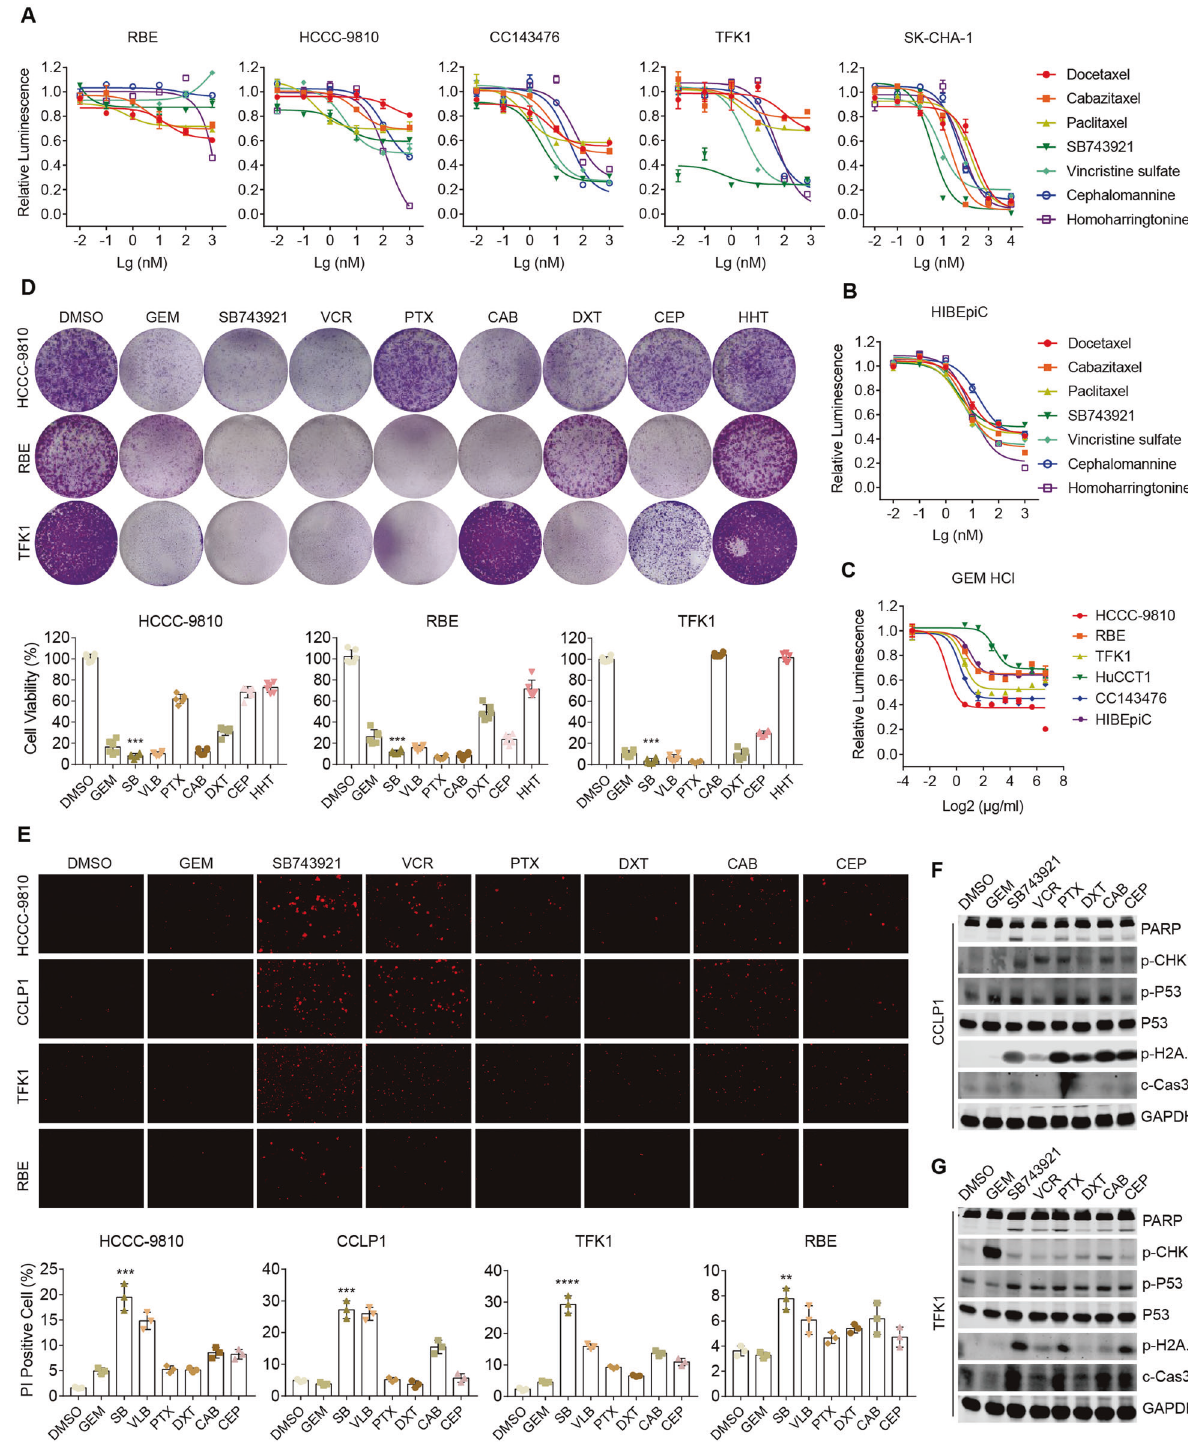
Fig. 2 The therapeutic effect of SB743921 on CCA cell lines. A , B Cell sensitivity to drugs treatment. CCA cell line HCCC-9810, RBE, CC143476, TFK1, SK-CHA-1, and normal counterpart cell line HIBEpiC were treated with drugs at gradient concentrations (0.001, 0.01, 0.1, 1 μ M) for 72 h. Values shown in the chart are the mean percent viability of control ± SD obtained from three independent experiments. C Cell sensitivity to gemcitabine treatment. D Colony formation assay of HCCC-9810, RBE, and TFK1 cells after drugs treatment (0.01 μ M, 7 days). Drugs were paclitaxel (PTX), docetaxel (DXT), cabazitaxel (CAB), vincristine (VCR), and cephalomannine (CEP), homoharringtonine (HHT) or gemcitabine (GEM). Bar graphs show representative data from three independent experiments. E Cell viability assessment of HCCC-9810, CCLP1, TFK1, and RBE cells treated with drugs (0.25 μ M, 24 h) by PI staining. Bar graphs show the mean percentage of PI-positive cells from three independent experiments. F , G Immunoblot analyses of the expression of PARP, p-CHK1, p-P53, p-H2A.x, and c-Caspase3 in CCLP1 and TFK1 cells after drugs treatment (0.25 μ M, 24